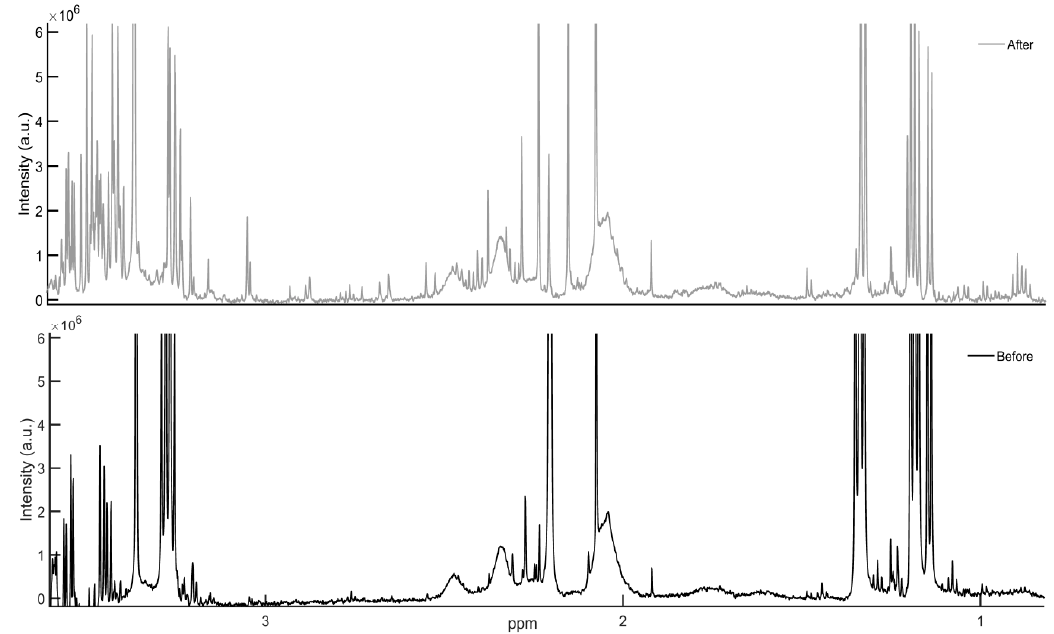
Figure 2. 600 MHz 1 H-NMR CPMG spectra of metabolic intensities in one patient’s bronchoalveolar lavage fluid obtained before (black) and after CPB (grey). The position of a signal is a characteristic of a given compound, while the area under the signal is proportional to the compound’s concentration. An increased number is observed in the signals of sample collected after CPB.